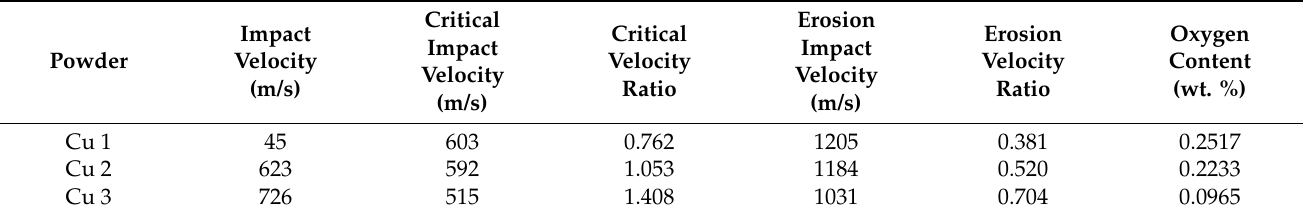
Table 4. Cold spray processing parameter-based critical velocity calculator outputs and analytically identified oxygen